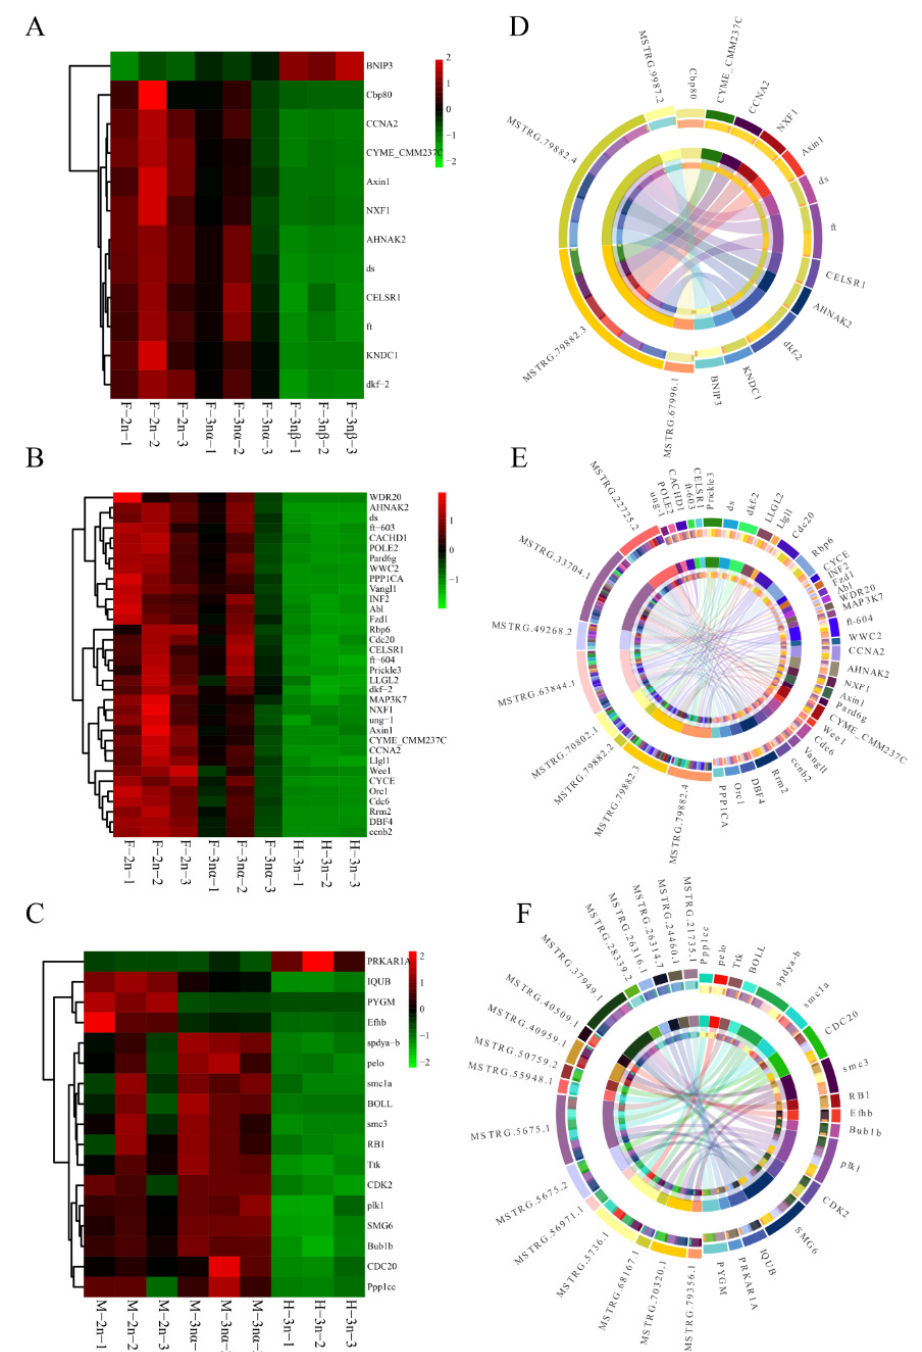
Figure 5. Identification of core lncRNA–mRNA networks for the gametogenesis arrest of sterile triploid oysters. The expression of core genes involved in the pathways of interest in F-3n β group ( A ), HF-3n group ( B ), and HM-3n group ( C ); the core networks of lncRNA–mRNA of F-3n β group ( D ), HF-3n group ( E ), and HM-3n group ( F ); targeted genes are listed in the right hemisphere, lncRNAs in the left hemisphere, and the interline represents targeted relationships.